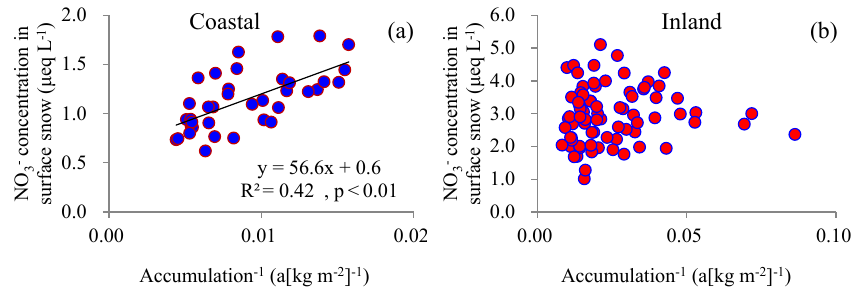
Figure 6. The relationships between NO − concentration and inverse snow accumulation rate in surface snow in coastal (a) and inland (b) 3 Antarctica. Least-squares regressions are noted with solid line and are significant at p< 0 .